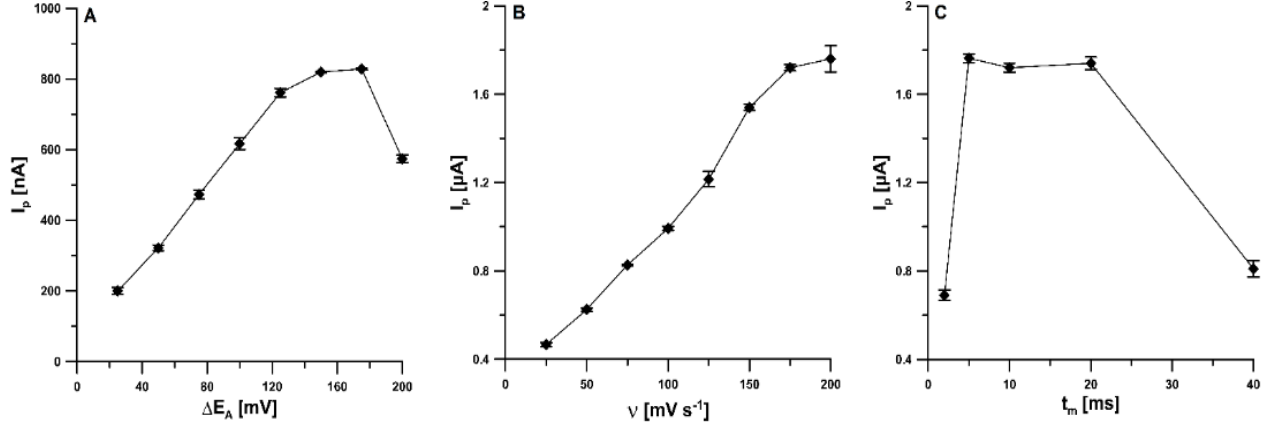
Figure 7. The dependence of ∆ E A ( A ), ν ( B ), and t m ( C ) on 1 × 10 − 8 mol L − 1 TST signal. The DPAdSV parameters: E Pb dep. and TST acc. of − 1.1 V and E Pb dep. and TST acc. of 120 s. The mean values of I p are given with the standard deviation for n = 3.